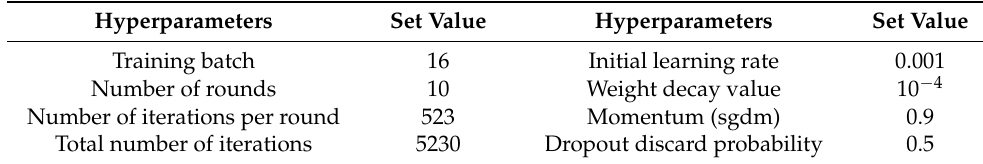
Table 3. Model hyperparameter settings.